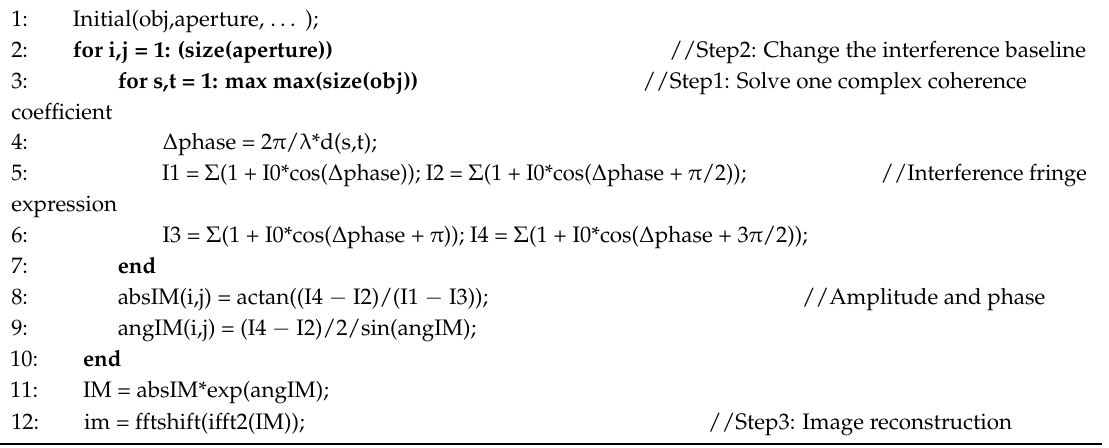
Algorithm 1. Imaging process and reconstruction algorithm. Solving fringes and image